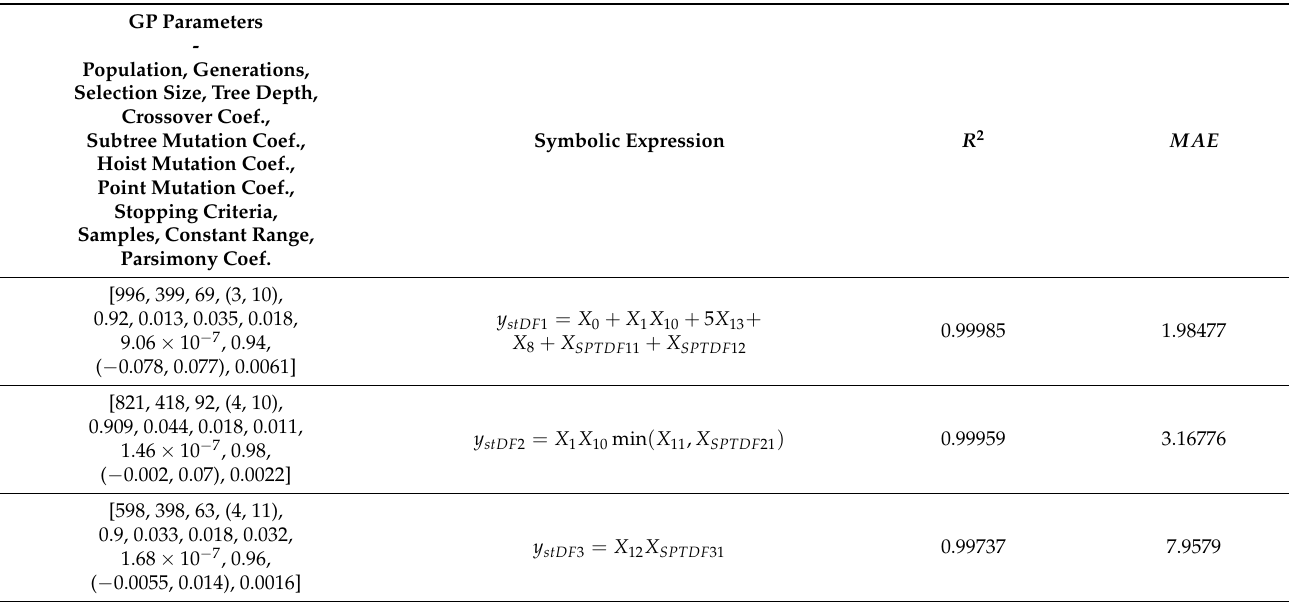
Table 8. Three best symbolic expressions for starboard torque estimation with decay state coefficients with corresponding R 2 and MAE score. GP Parameters -